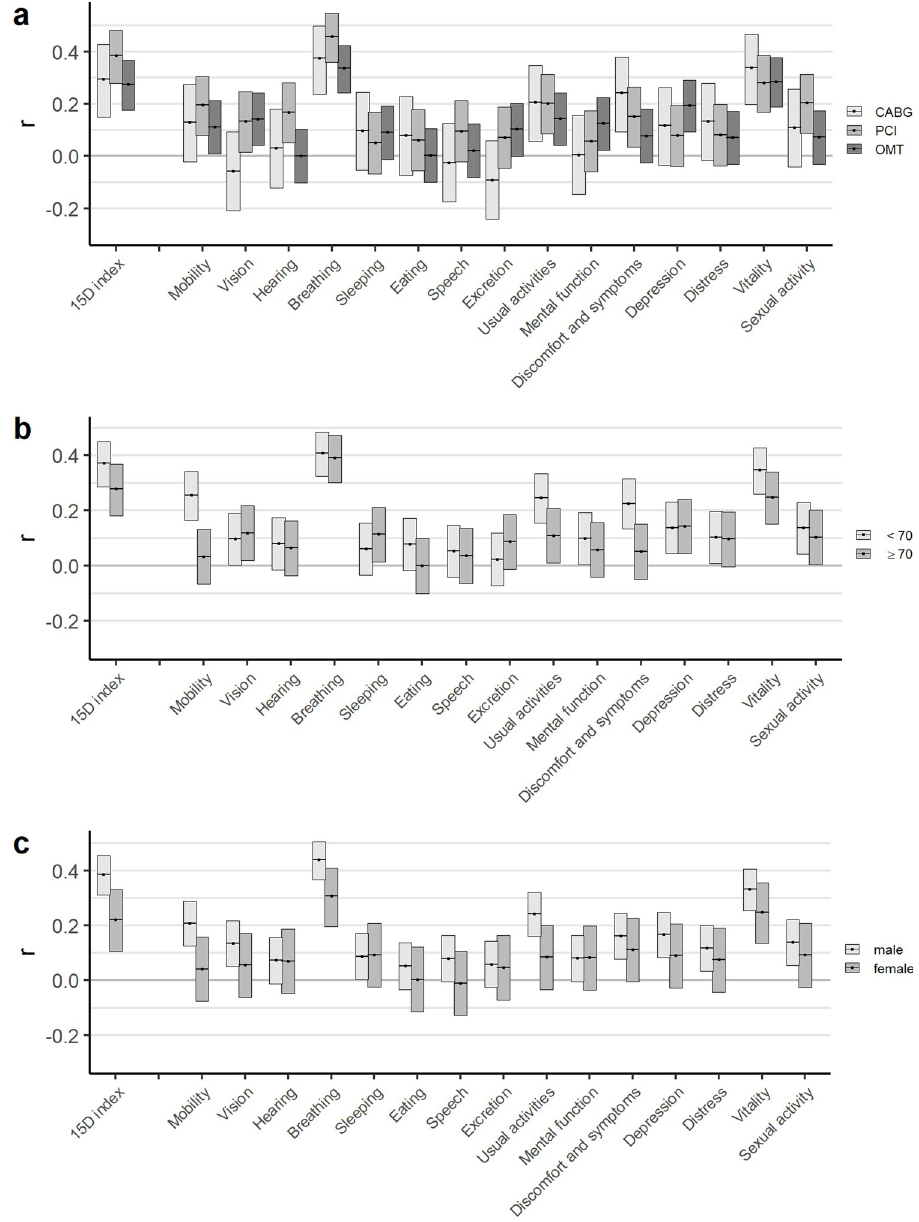
Fig 2. Spearman correlation coefficients (95% confidence intervals) between one-year changes in the CCS and the 15D and its dimensions in subgroups. (a) Correlations by treatment groups; (b) Correlations by age groups, < 70 and � 70; (c) Correlations by